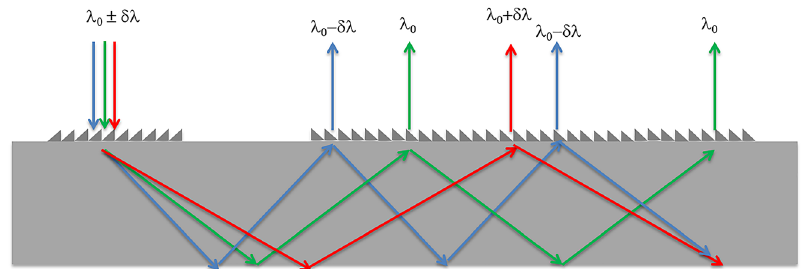
Figure 23: Spectral spread compensation in a symmetric in-coupler/out-coupler wave- guide combiner.